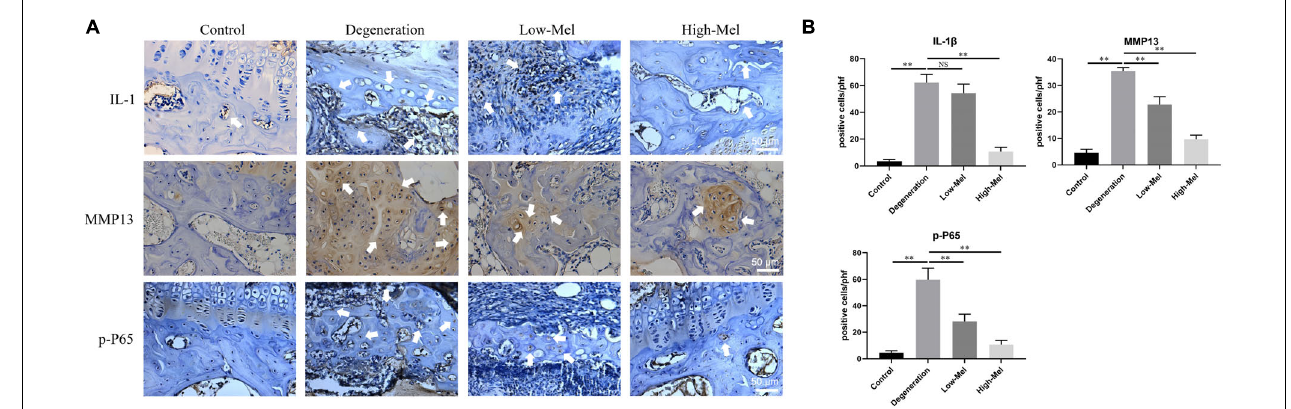
FIGURE 8 | In vivo studies of melatonin (Mel) take effect on inflammatory response and matrix degradation activated by NF- κ B pathway. (A) Immunohistochemical staining of IL-1 β , matrix metalloproteinase-3 (MMP3), and p-P65 in rat endplate (EP) tissues. (B) Quantitation of IL-1 β , MMP3, and p-P65 ( n = 5, ∗ P < 0.05, ∗∗ P <